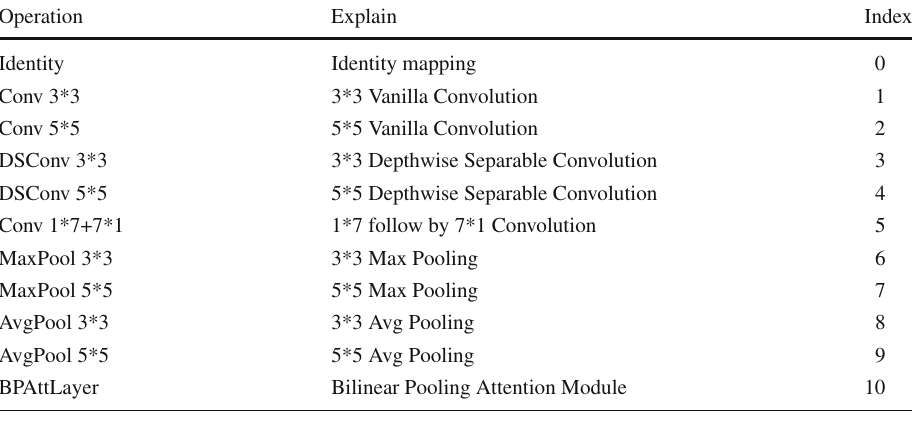
Table 1 The operation space and corresponding interpretation